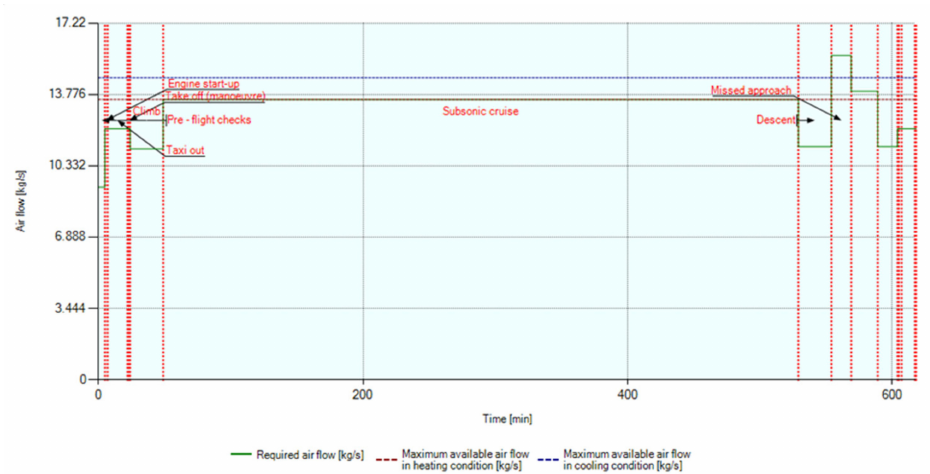
Figure 23. Estimation of air mass flow supplied by ECS through engine bleed and CAU for a wide body aircraft.